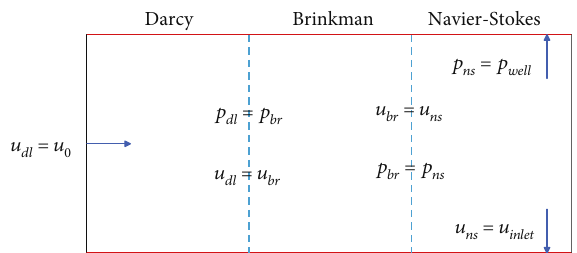
Figure 1: Simpli fi ed model of three fl ow fi